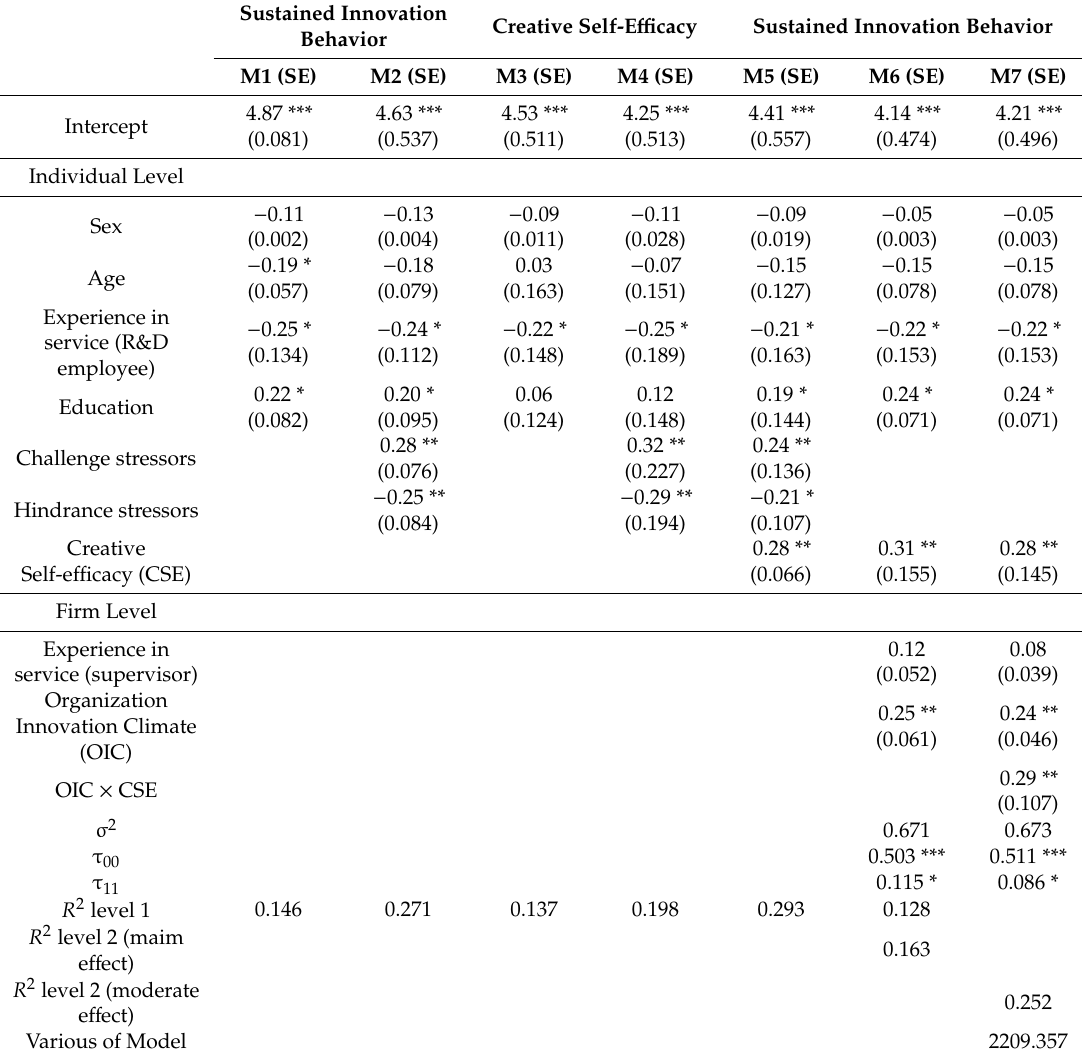
Table 3. Results of the multilevel model